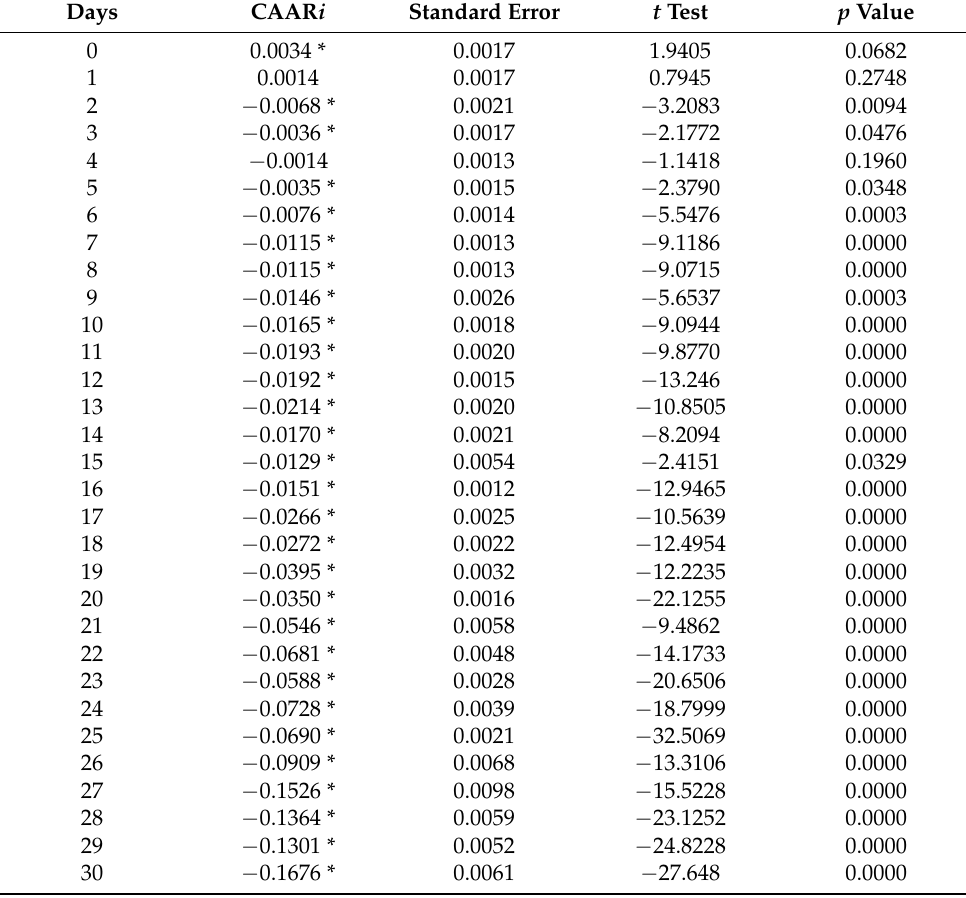
Table A1. Daily cumulative average abnormal return across all